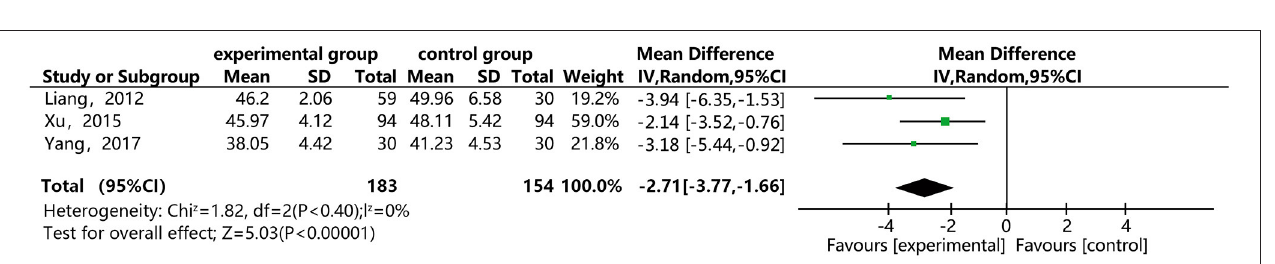
FIGURE 7 | Meta-analysis forest map for the effect of DSP combined with aspirin on LDL-C in patients with CHD.